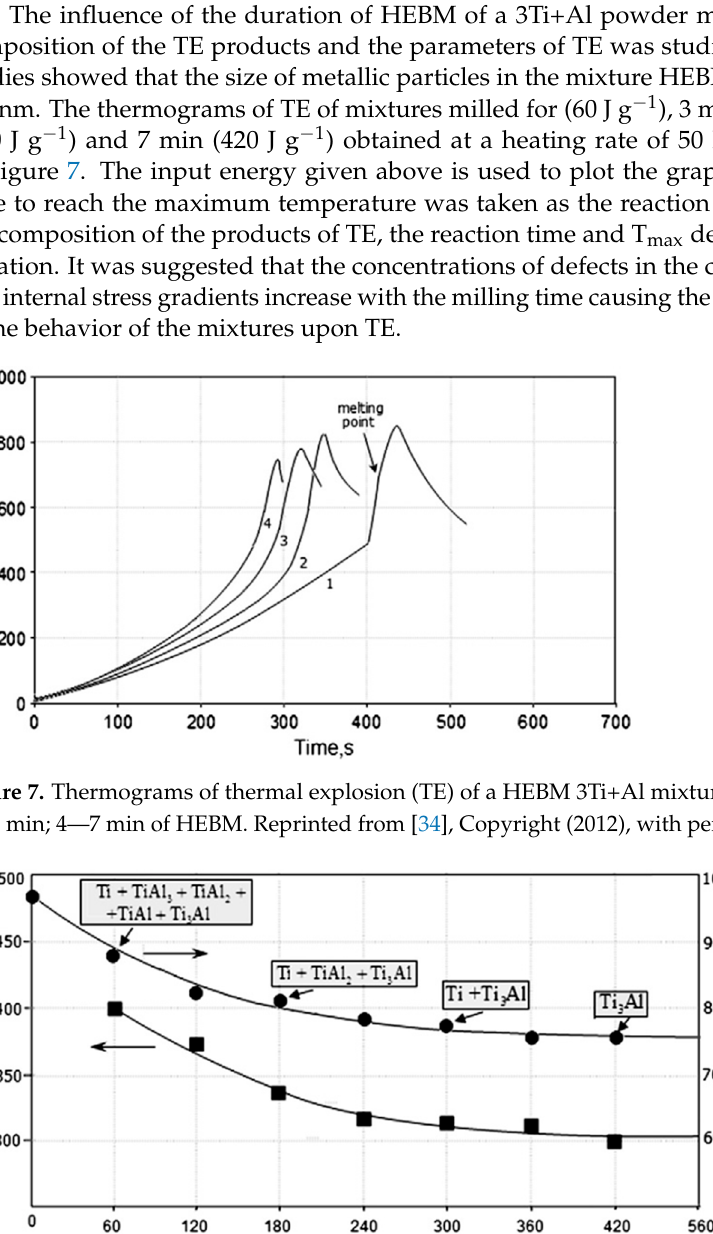
( b ) Figure 6. Microstructure (BSE images) of the composite particles of Ti-C-3Cu after TE ( a ), 10 min of HEBM ( b ), different magnifications. Reprinted from [38], Copyright (2021), with permission from Elsevier.